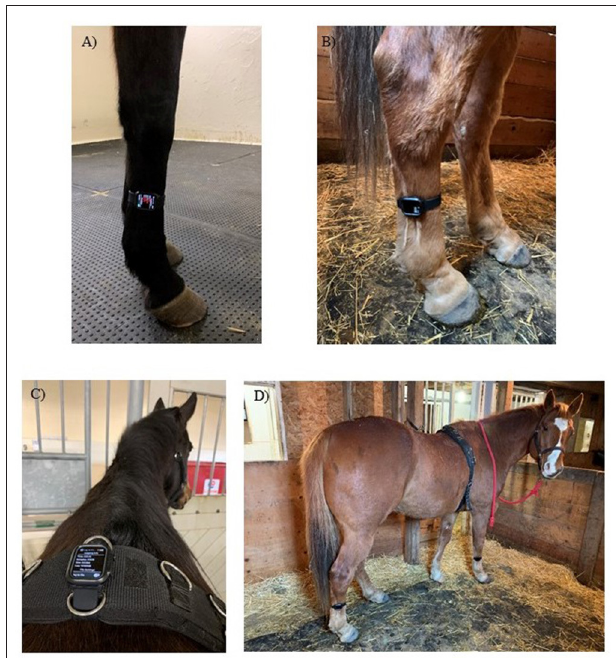
FIGURE 1 | The locations in which the IMU was placed for movement analysis trials. (A) right forelimb cannon bone (metacarpus), (B) right hindlimb cannon bone (metatarsus), (C) withers attached to a surcingle and (D) IMUs at all three